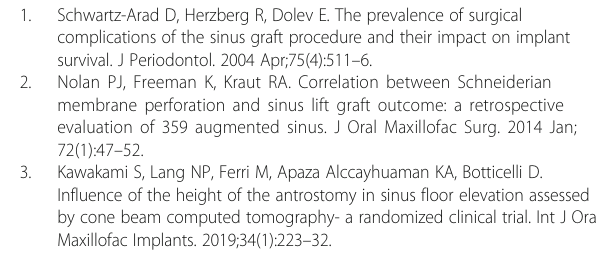
Table 6 Sinus mucosa thickness at the various periods of evaluation T0 T1 T2 Δ T1 – No-